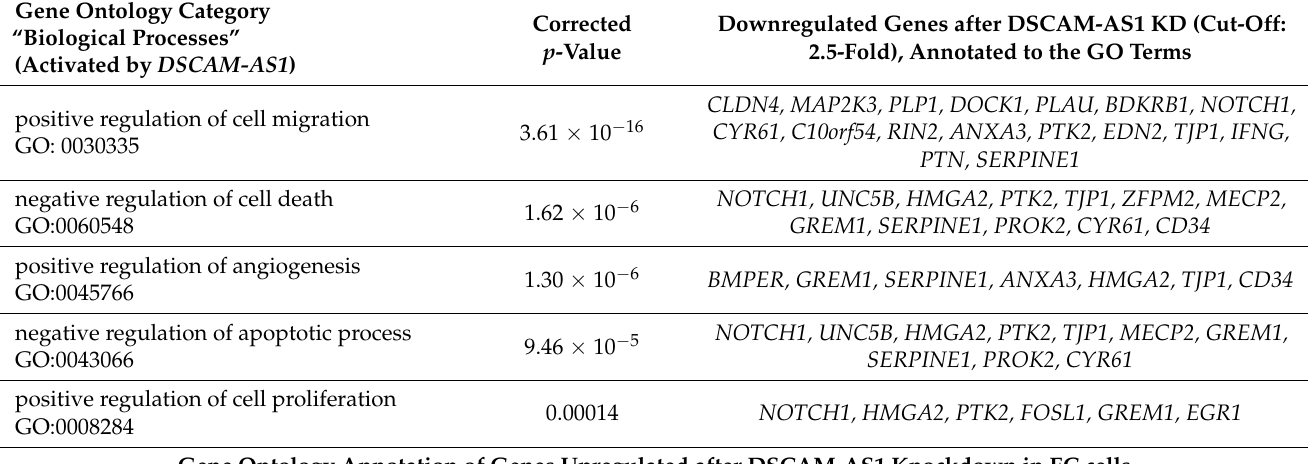
Table 3. After DSCAM-AS1 knockdown (KD) by >90% in endometrial cancer (HEC-1B) cells, the regulated genes (at least 2.5-fold change) were first annotated to the Gene Ontology (GO) category “Biological processes” using the software GOTermFinder (Version 22.9.2021) (https://go.princeton.